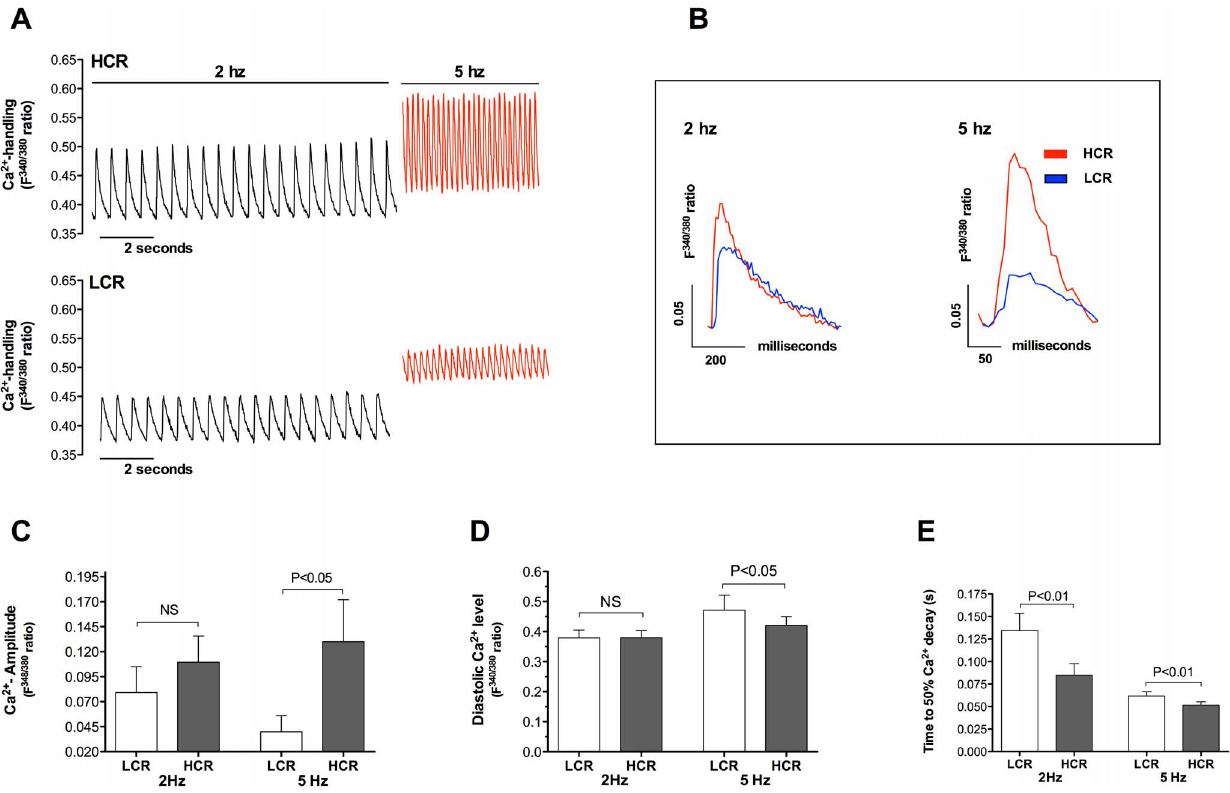
Figure 3. Ca 2 + -handling properties determined in isolated FURA2/AM loading atrial myocytes during increasing stimulation frequency from 2–5 Hz. A, Exemplary recordings of Ca 2 + -transients in Low Capacity Runner (LCR)- and High Capacity Runner (HCR) rats. B, Exemplary tracings of one single twitch Ca 2 + transient at 2 hz (left panel) 5 hz (right panel) with comparison of LCR and HCR (normalized diastolic Ca 2 + levels). C, Ca 2 + -amplitude during systolic contraction of the atrial myocytes. D, Diastolic Ca 2 + -level measured at end diastole. E, Time to 50% Ca 2 + -removal during diastole. All Ca 2 + -recordings are presented as the 340/380 ratio of FURA2/AM. n=5 animals, n=4 2 6 cells from each animal. Data are presented as mean 6